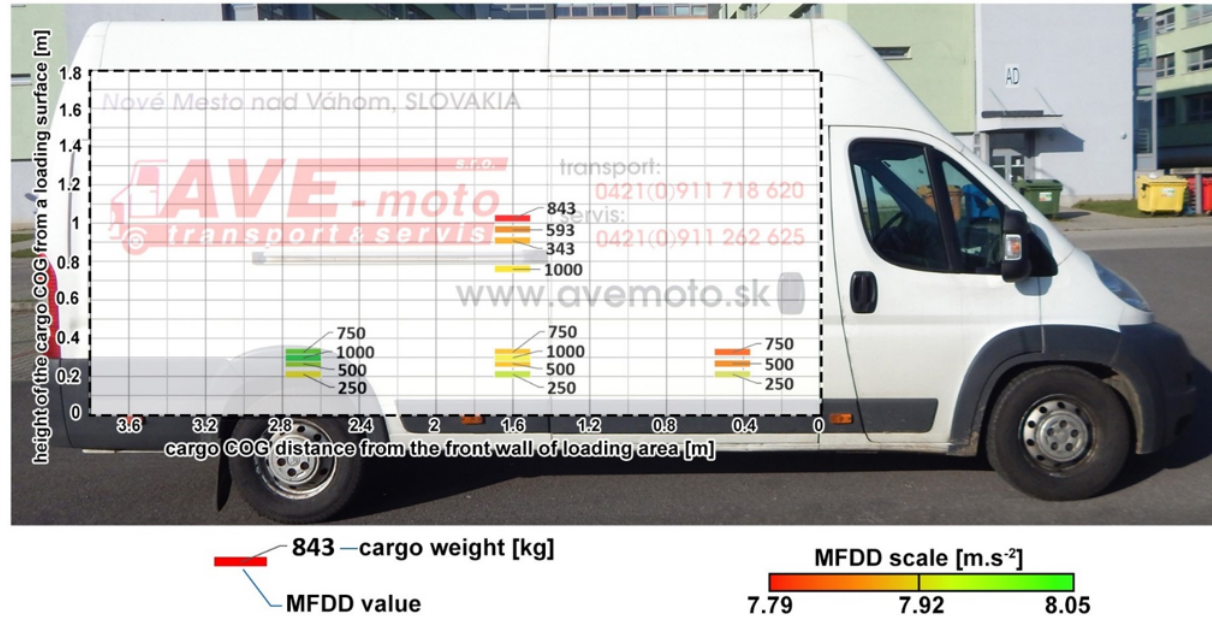
Figure 9: Influence of cargo location and its weight on braking deceleration Source: Authors